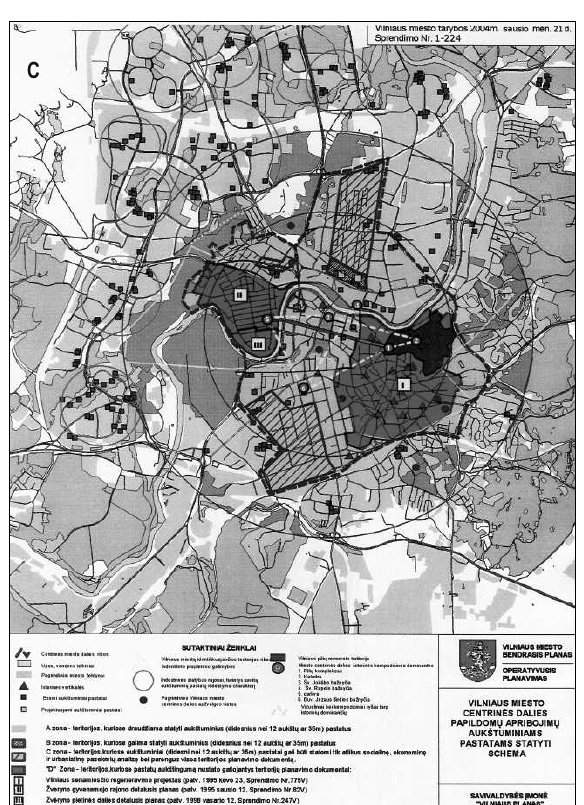
Fig 9. Proposals regulating building height in Vilnius city central